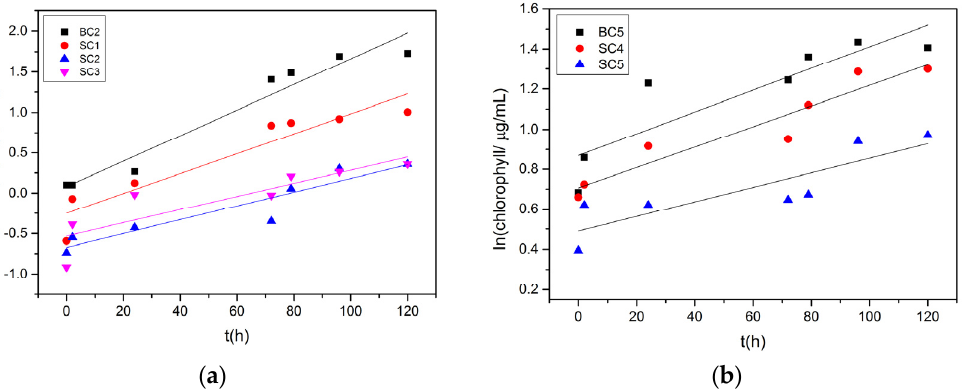
Figure 3. Logarithmic plots of the variation of chlorophyll concentrations as a function of time during precipitation of calcium carbonate in the presence of zinc under illumination and in the presence of A. obliquus culture and nutrient medium. ( a ) Ca t = C t = 1.7 mM, σ calcite = 0.68; ( b ) Ca t = C t = 3.4 mM, ◦ C, pH σ calcite = 2.28; 25 initial 8.50, 0.15 M of